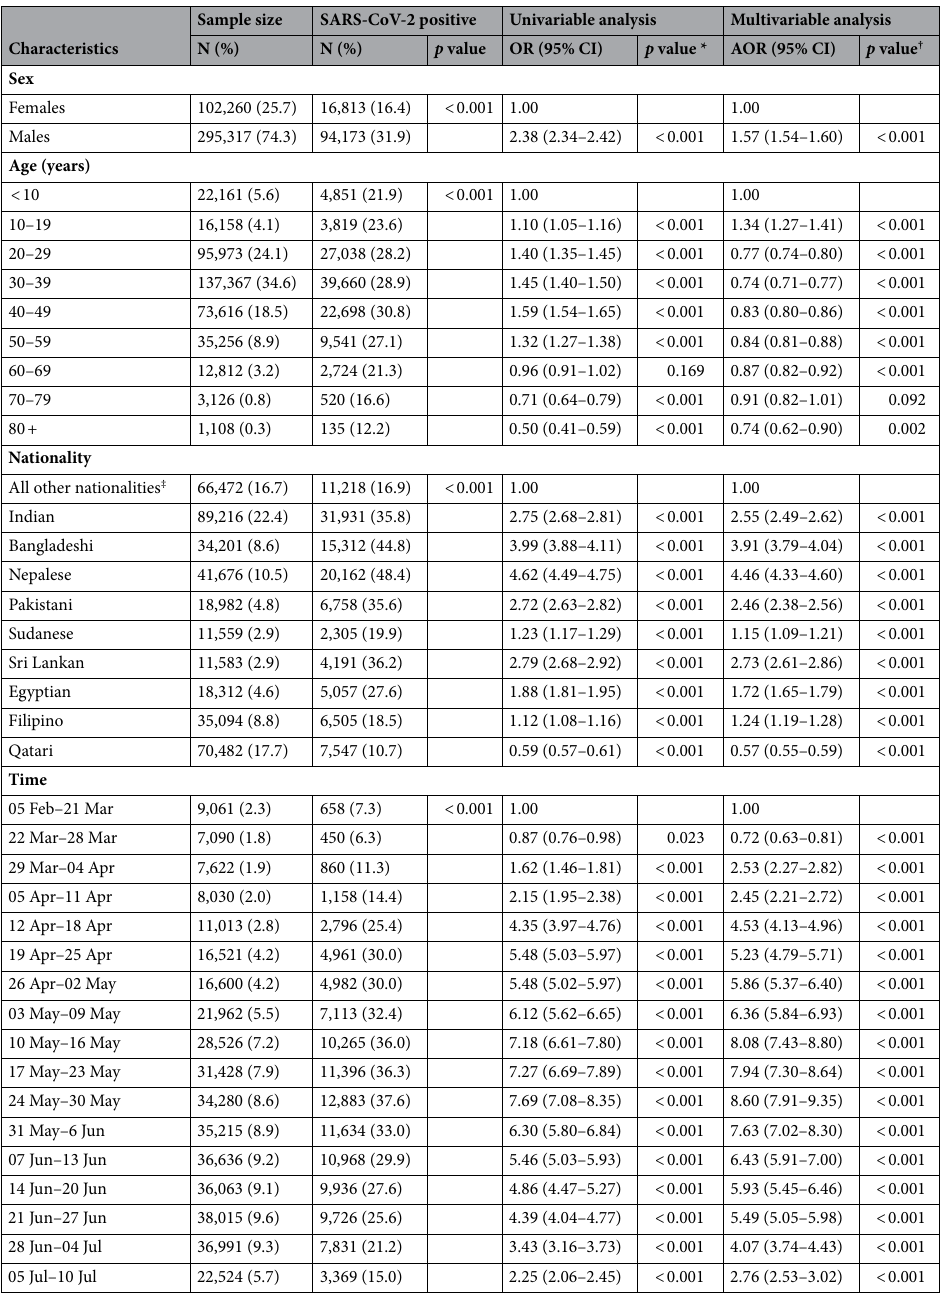
Table 1. Associations with current infection in Qatar based on analysis of the national SARS-CoV-2 PCR testing and hospitalization database. AOR adjusted odds ratio, CI confidence interval, OR odds ratio, PCR polymerase chain reaction. *Covariates with p value ≤ 0.1 in the univariable analysis were included in the multivariable analysis. † Covariates with p value ≤ 0.05 in the multivariable analysis were considered predictors of SARS-CoV-2 current infection. ‡ These include all other nationalities residing in